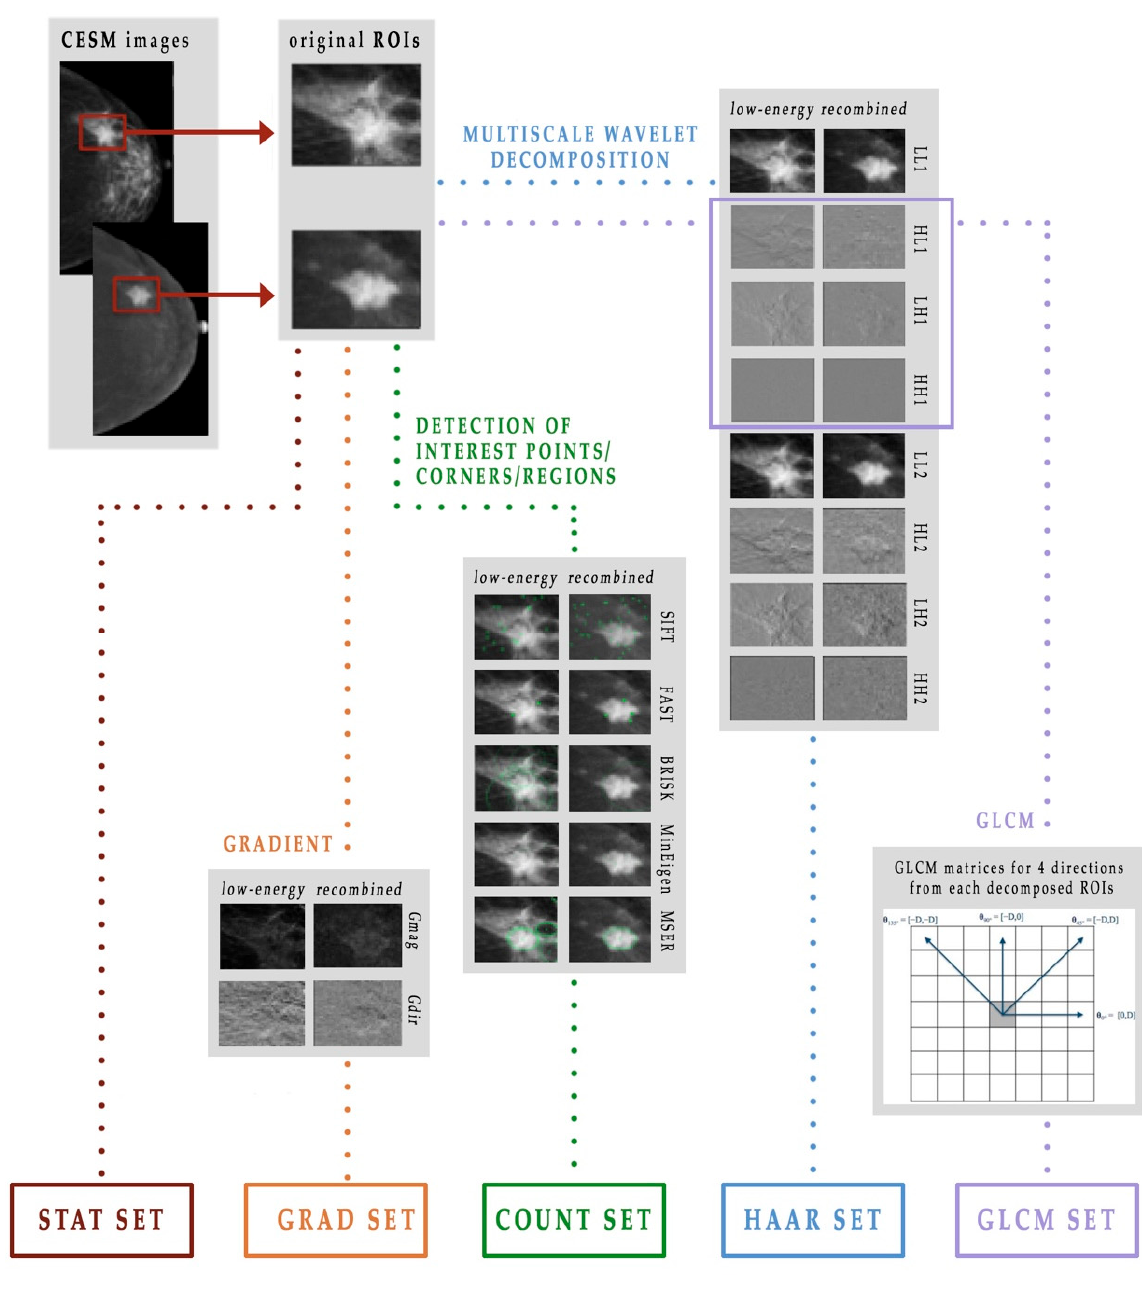
Figure 3. Scheme of the feature extraction process.